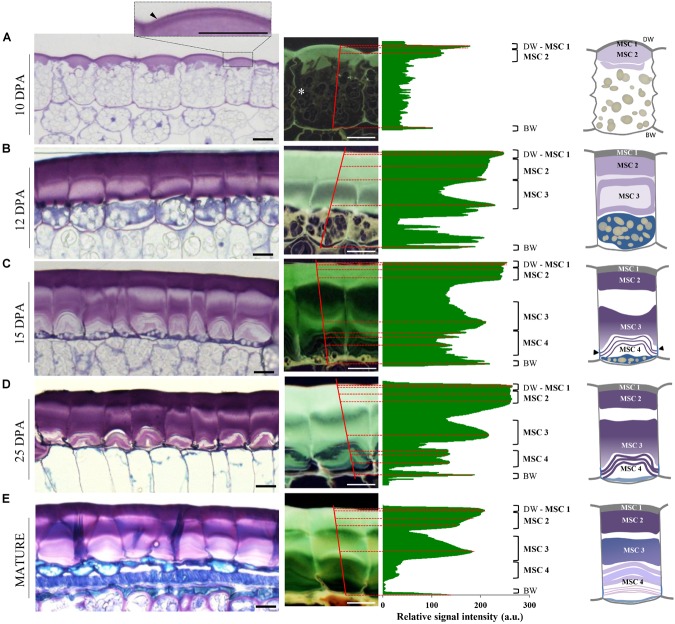
Flax mucilage is biosynthesized and organized in several successive layers inside MSCs. (A–E) Cytological analysis of flax seed coat sections from RIL 44 during seed development stained with toluidine blue O 0.01%. Plot profiles of the toluidine blue O relative signal intensity of representative mucilage secretory cells (right). Plot position corresponds to the red lines that span cells. Numbers on the right correspond to the mucilage layers observed, from MSC 1 to MSC 4. White asterisk in (A) shows the radial wall at 10 DPA. Before 10 DPA, the mucilage biosynthesis starts from the top of the cells in the apoplast, under the distal primary cell wall (dark arrowhead in A). (B) At 12 DPA, mucilage polysaccharide deposition continues until the middle of the cells. (C) At 15 DPA, while starch granules have been reduced to the bottom of the cells, the number of mucilage polysaccharides cell sublayers in MSC 4 has increased. (D) At 25 DPA, the mucilage polysaccharide cell layers appear unchanged. Note that the toluidine blue O staining intensity is darker in sublayers of MSC 4. (E) When seeds reach the mature stage, the number of mucilage polysaccharide sublayers has not changed in the upper part of the MSCs, but they are uncountable in the lower part. On the middle panels, the flax seed coat sections are presented during seed development by a relative signal that allow us to determine the different layers of flax MSCs. On the right panel, we present a schematic view of the organization of the four mucilage layers identified in this study and their polarized biosynthesis. Black arrowheads indicate radial wall reinforcement. BW, basal primary cell wall; DW, distal primary cell wall; MSC, mucilage secretory cell. Bars = 15 μm.